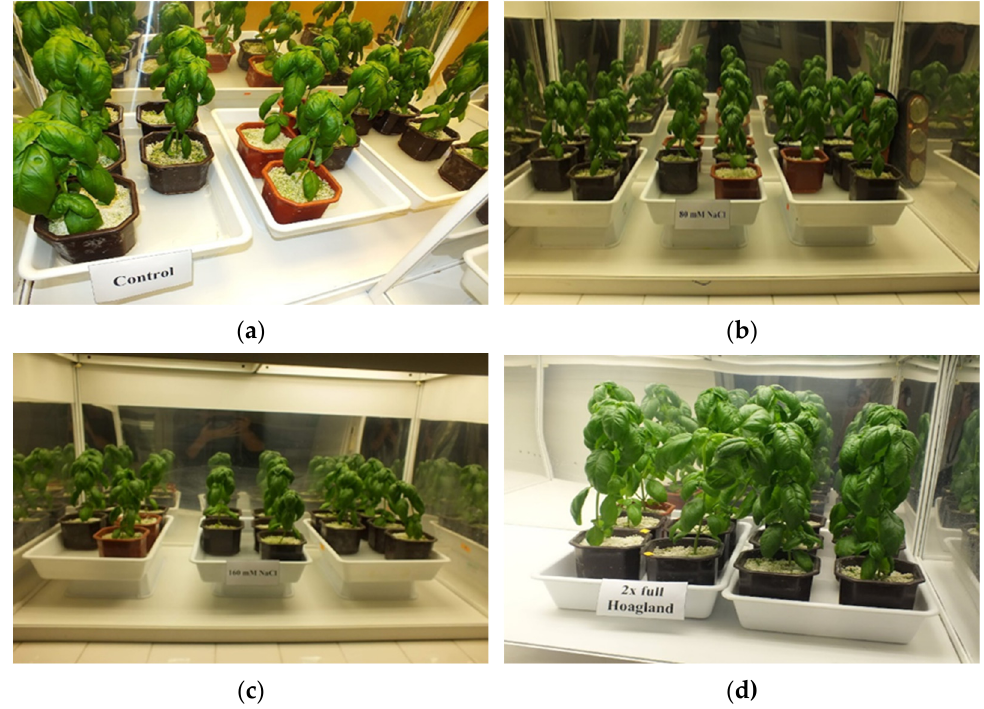
Figure 2. Design of the experiment: ( a ) Control (½ Hoagland’s solution); ( b ) ½ Hoagland’s solution with added NaCl (80 mM); ( c ) ½ Hoagland’s solution with added NaCl (160 mM); ( d ) 4/2 Hoa- gland’s solution.